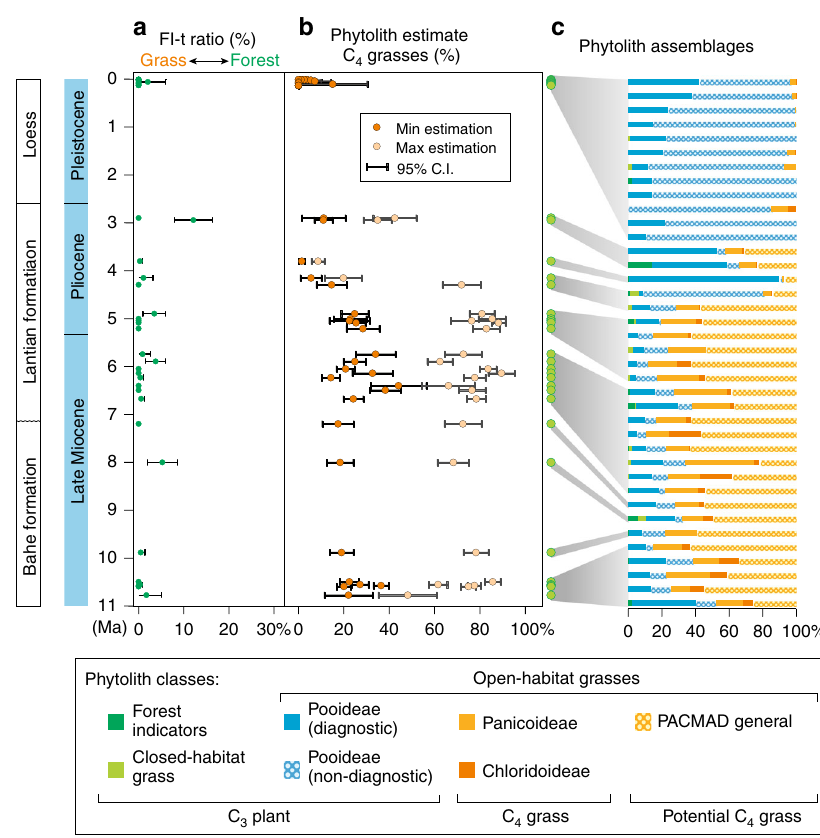
Fig. 3 Phytolith records since ~11.0Ma from Lantian, central China. a Tree cover estimated by phytolith assemblages by comparing forest indicator phytoliths (FI TOT) and diagnostic grass phytoliths (GSSC), FI-t ratio = FI TOT/(FI TOT + GSSC)%. b Potential C 4 grasses. The minimum estimation is calculated from PAN + CHLOR (Panicoideae + Chloridoideae) (Eq. 1) and the maximum estimation from PACMAD (a clade of grasses that includes the grass subfamilies Panicoideae – Aristidoideae – Chloridoideae – Centothecoideae – Micrairoideae – Arundinoideae – Danthoniodeae) (Eq. 2). The error bars are calculated from the con fi dence intervals (95% unconditional case) of each sample using the total count as the sample size. c Phytolith assemblages. For detailed information about these data and equations, see the Methods and Supplementary Table